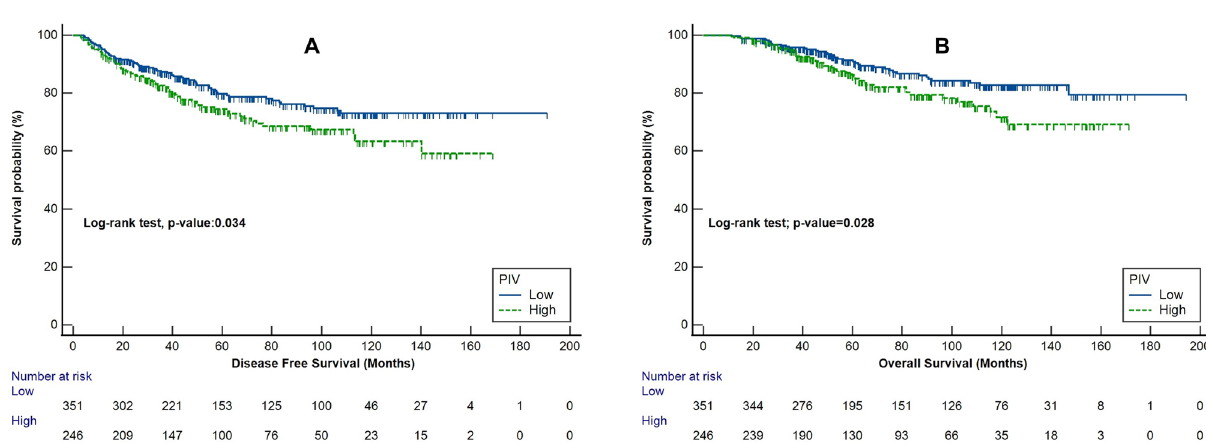
Figure 1. Kaplan-Meier plots of survival endpoints in different Pan-Immune-Inflammation-Value (PIV) groups (low versus high): ( A ) disease-free survival; ( B ) overall